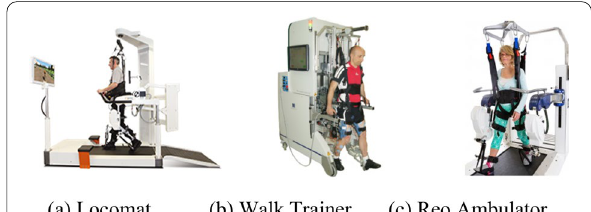
Figure 1 Lower limb exoskeleton rehabilitation training robot